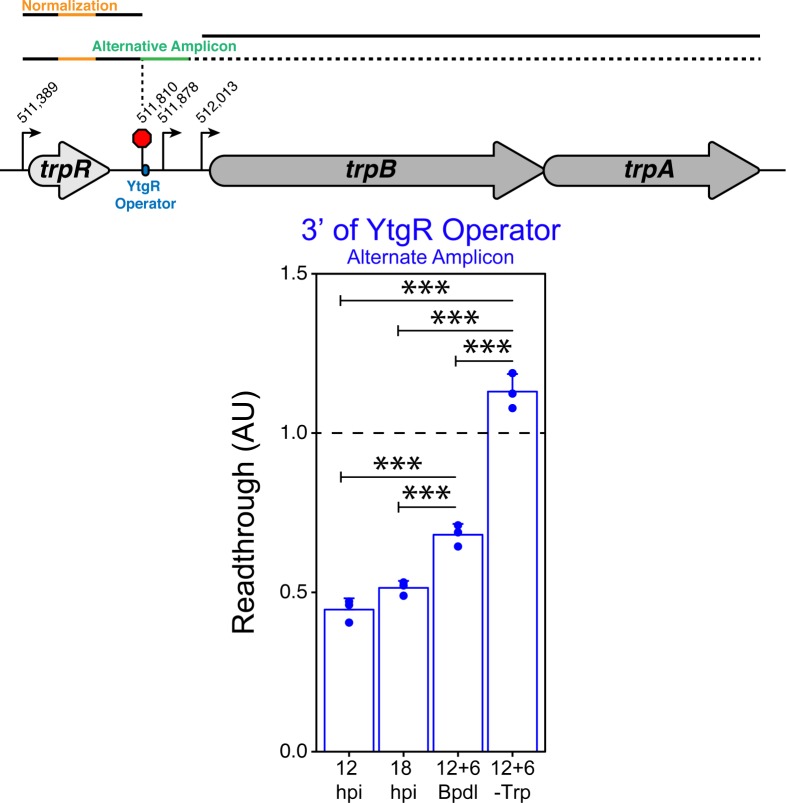
Alternative amplicon 3’ of the YtgR operator site indicates confirmatory increase in transcription readthrough.(Top) Graphical schematic of RT-qPCR amplicons utilized to assess transcriptional readthrough in C. trachomatis-infected HeLa cells at the YtgR operator site. Black lines represent possible transcript species. Colored segments of line indicate unique amplicons. The dotted line indicates that the transcripts reading through the YtgR operator site may prematurely terminate at another site or readthrough the entire operon. (Bottom) RT-qPCR analysis of transcription readthrough at the YtgR operator site in C. trachomatis-infected HeLa cells. Following Bpdl-treatment, readthrough is increased relative to mock-treated cultures 3’ of the YtgR operator site. Statistical significance was determined by One-way ANOVA followed by post-hoc pairwise t-tests with Bonferroni’s correction for multiple comparisons. N = 3. *=p < 0.05, **=p < 0.01, ***=p < 0.005.